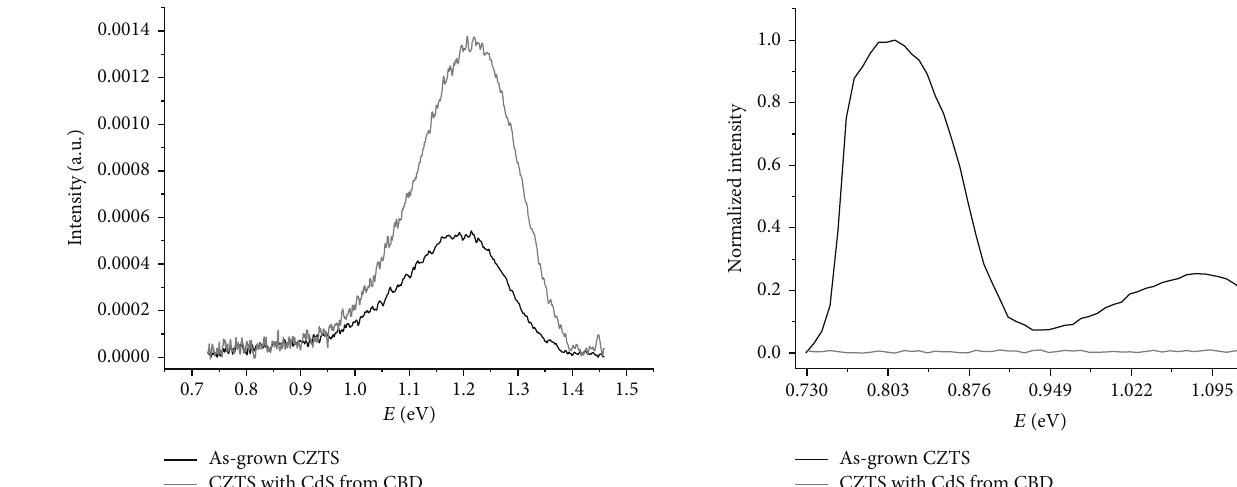
Figure 8: PL spectra at 300K ( 𝜆 the as-grown CZTS samples after the etching procedure in aqueous HCl (black line) and of CdS/CZTS solar cells (grey line).